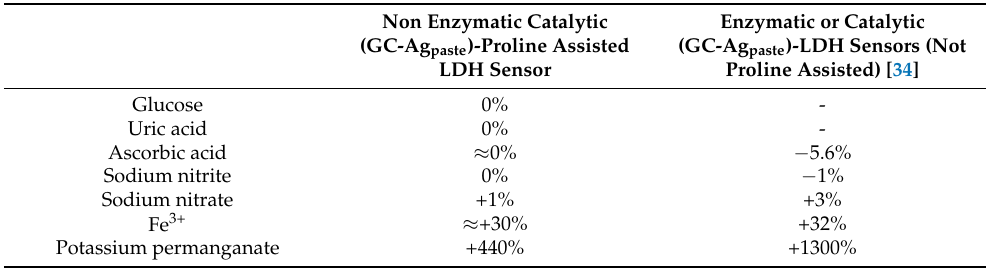
Table 2. Interferences in hydrogen peroxide determination expressed as the percentage response variation to H 2 O 2 using the non-enzymatic catalytic (GC-Ag paste )-proline-assisted LDH amperometric sensor and comparison with those observed in the previously developed enzymatic or simply catalytic (GC-Ag paste )-LDH sensors [34]. Each added interfering species had a final concentration in solution equal to that of hydrogen